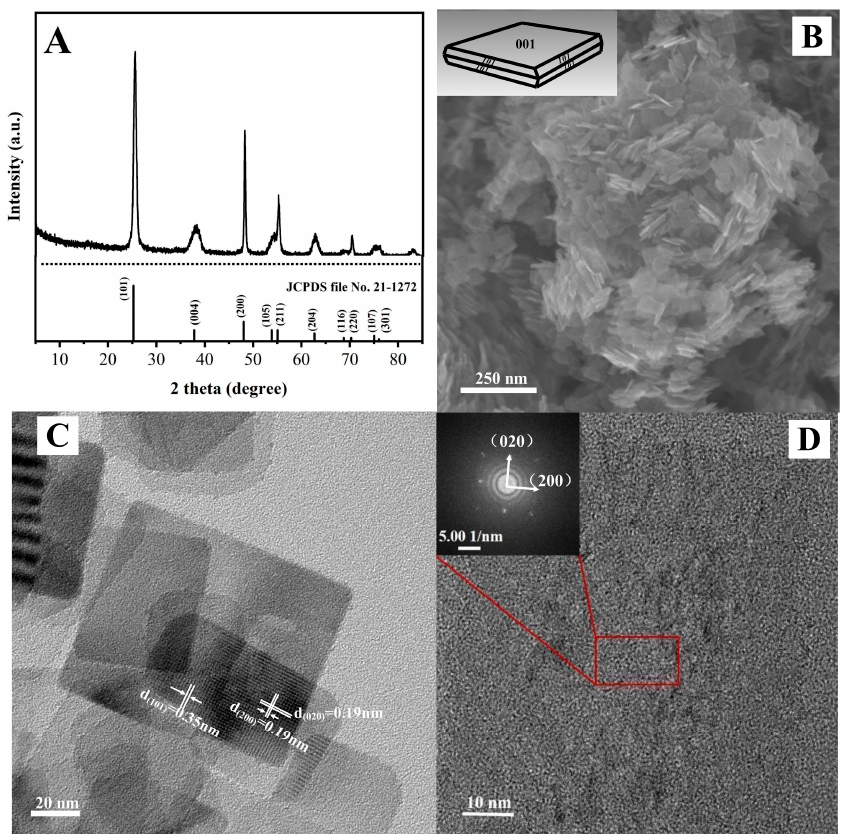
Figure 1. XRD patterns ( A ), SEM image ( B ), and HRTEM images ( C , D ) of the prepared TiO 2 parti ‐ cles.